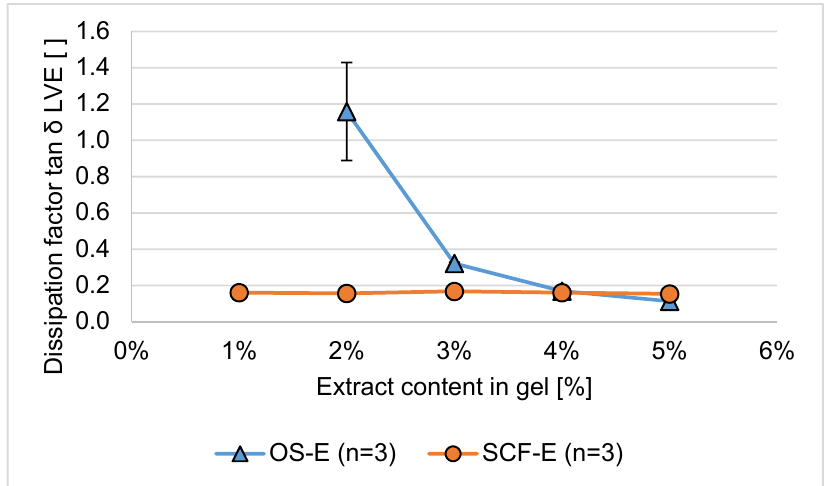
Figure 9. Gel strength (amplitude sweep) as a function of extract content in gels, stabilised by organic solvent and supercritical fluid extract; n = 3, mean ± SD.